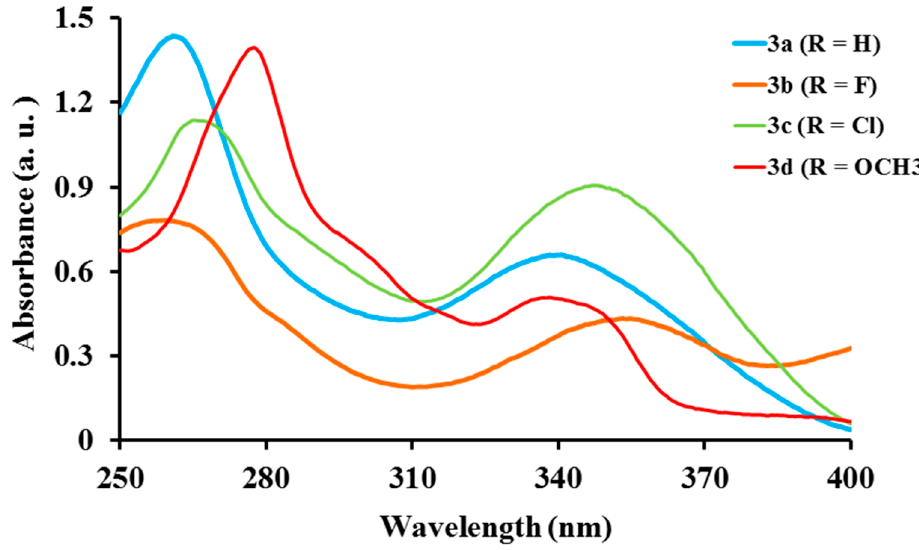
Figure 2. UV-Vis absorption spectra of 3a – d in chloroform (concentration 1.0 × 10 − 3 mol/L).